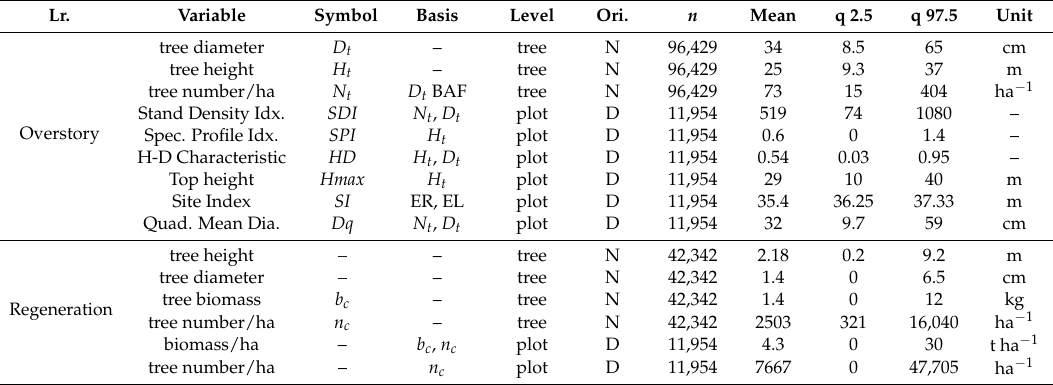
Table 2. Value characteristics of the base data set from the Bavarian State Forest inventory BSFI ( n = 11,954) used to analyze the influence of the overstory on the biomass of the regeneration fraction. Columns q 2.5 and q 97.5 show the 2.5% and 97.5% quantile, respectively. Column n denotes the number of data records used to calculate that range, as well as the mean of the variable considered. Column Ori. (origin) indicates whether the data were native (N) or derived by own computation (D). Further abbreviations are Lr. (layer), BAF (basal area factor), ER (ecoregion), and EL (elevation).